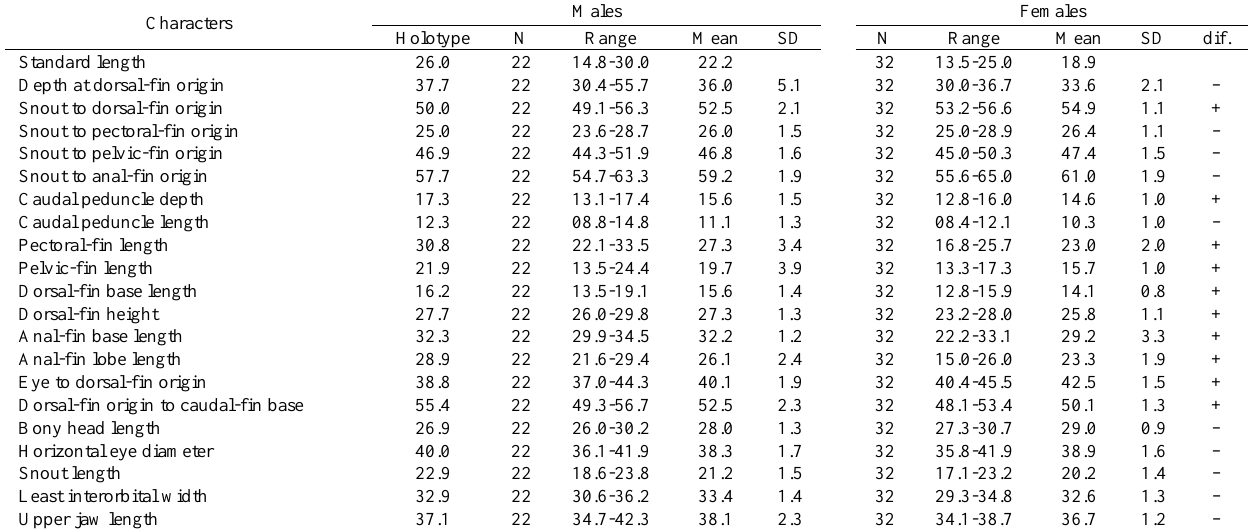
Table 2. Morphometrics of Lophiobrycon weitzmani . Standard length is expressed in mm; measurements through bony head length are percentages of standard length; the last four entries are percentages head length. A plus sign under the abbreviation dif. indicates there is a significant statistical difference between the males and females in the particular character indicated. All specimens are from the type locality, Brazil, Minas Gerais, rio Grande basin, LIRP 4366 (holotype), (remainder are paratypes) LIRP 4338, LIRP 4339, MZUSP 83353, MCP 34194. SD = Standard deviation.